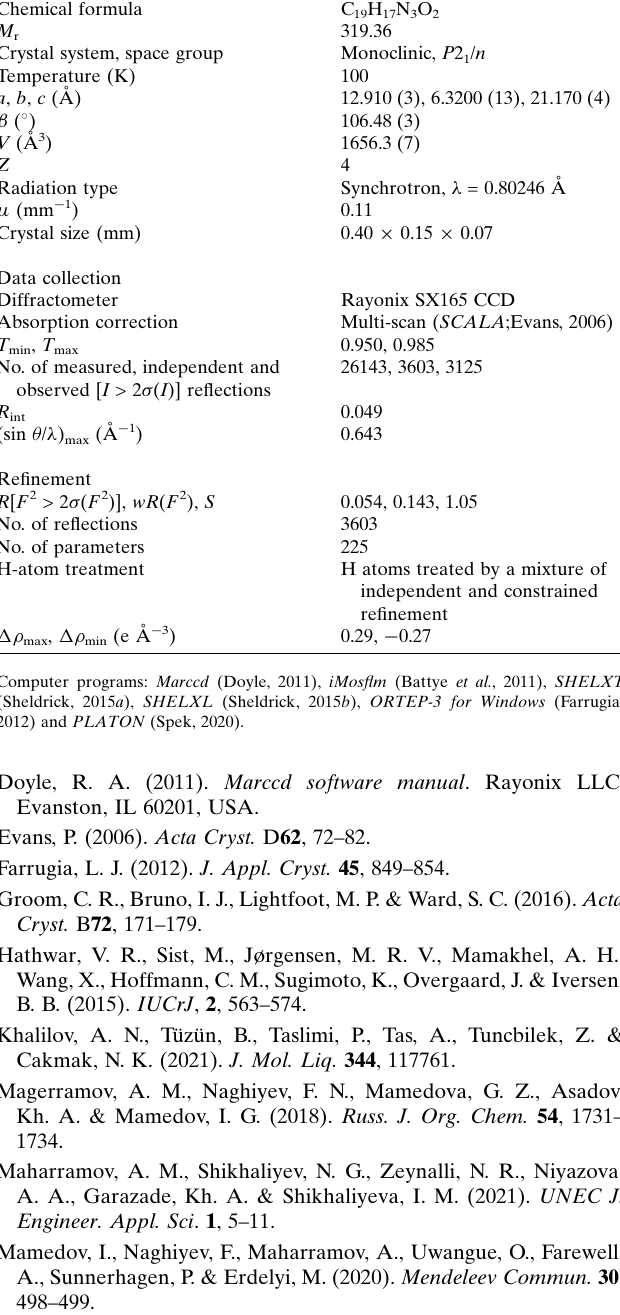
Crystal data Chemical